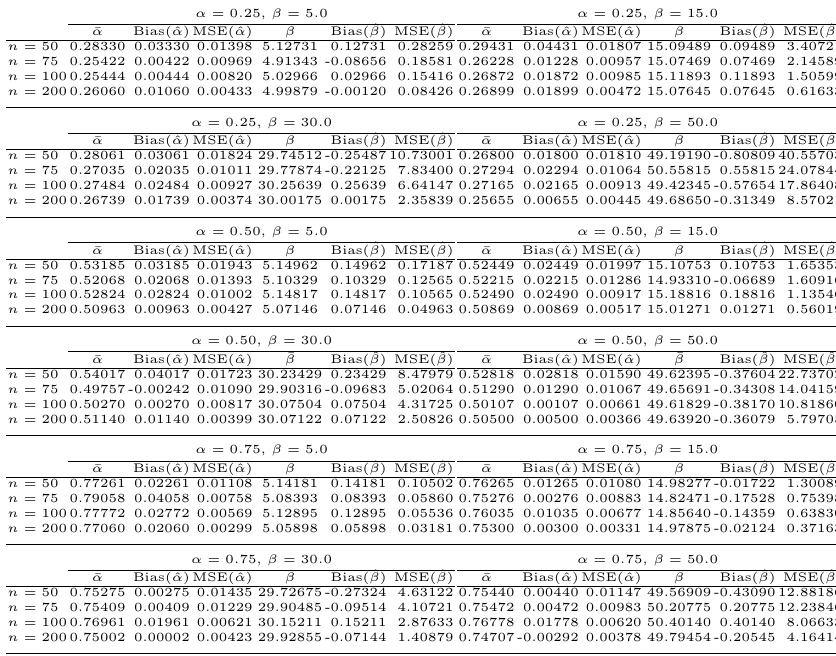
Table 4. The scaled Muth distribution: ML estimates. α = 0 . 25, β = 5 .